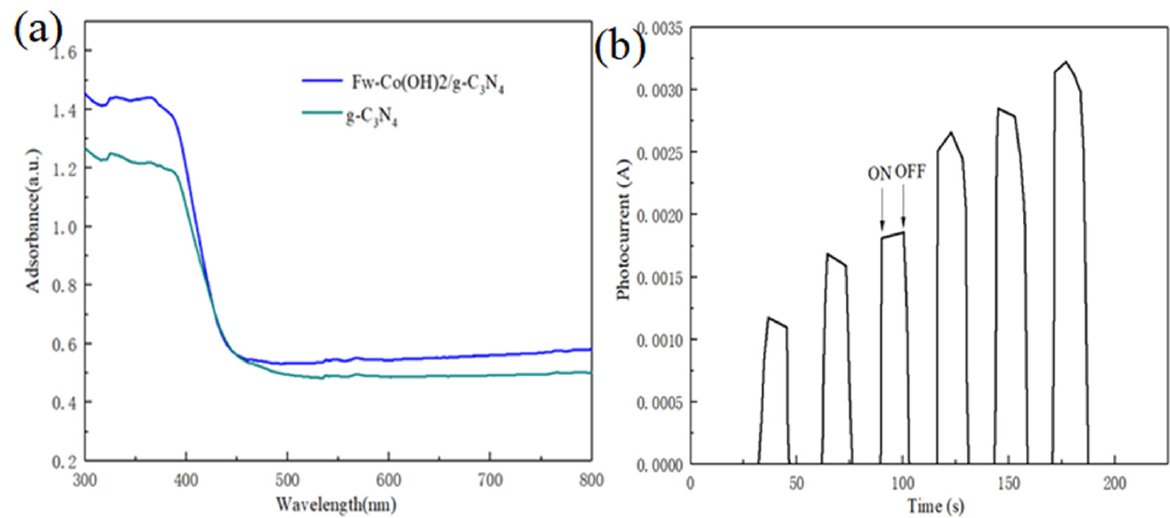
Figure 5. ( a ) UV–vis diffuse reflectance spectra of Fw-Co(OH) 2 /g-C 3 N 4 and g-C 3 N 4 ; ( b ) transient photocurrent responses of the Fw-Co(OH) 2 /g-C 3 N 4 sample in 1M Na 2 SO 4 aqueous solution under visible-light irradiation at 0.5 V vs. Ag/AgCl.